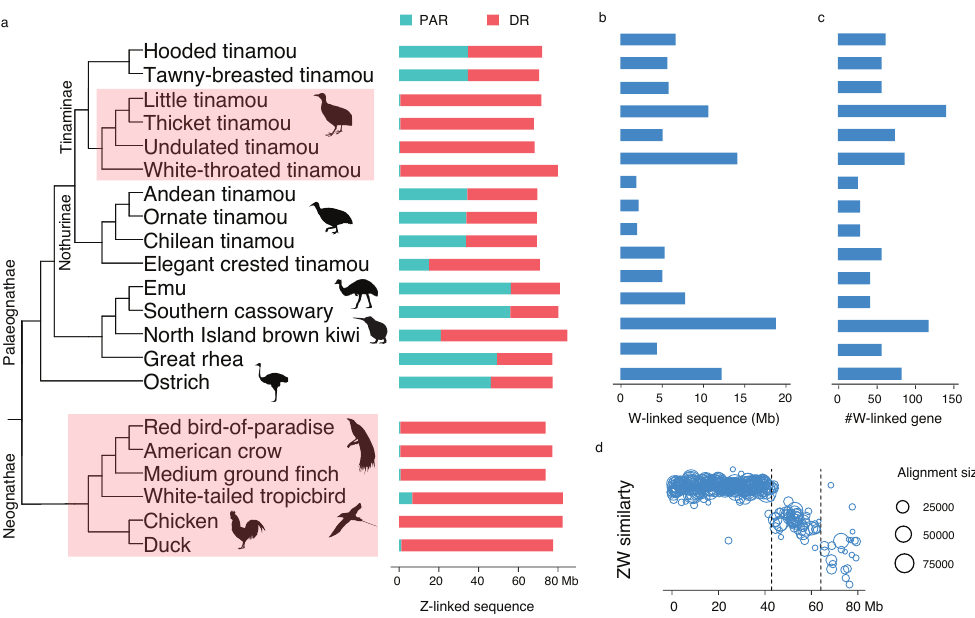
Figure 1. Identification of sex-linked sequences of birds. ( a ) The phylogeny contains the three major avian clades, showing the size of pseudoautosomal regions (PAR) and di ff erentiated region (DR) of sex chromosomes. ( b , c ) This study retrieved W-linked sequences and genes for palaeognathous birds by re-analyzing the data from Wang et al. (2019). ( d ) The sequence similarity between the Z and W chromosomes of the white-throated tinamou can be divided (by the dashed lines) into three evolutionary strata. Each dot represents a 100-kb window. The X -axis represents the positions on the Z